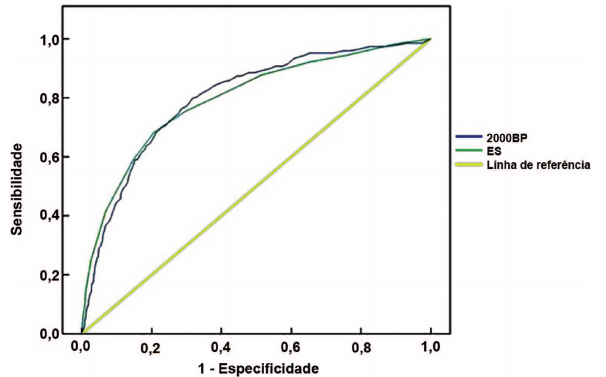
Fig. 1 - Curva ROC para o 2000BP e o ES na avaliação do poder de discriminação realizada em 3000 pacientes. 2000BP ROC = Curva ROC apresentada pelo escore 2000 Bernstein Parsonnet; ES ROC = Curva ROC resultante do EuroSCORE